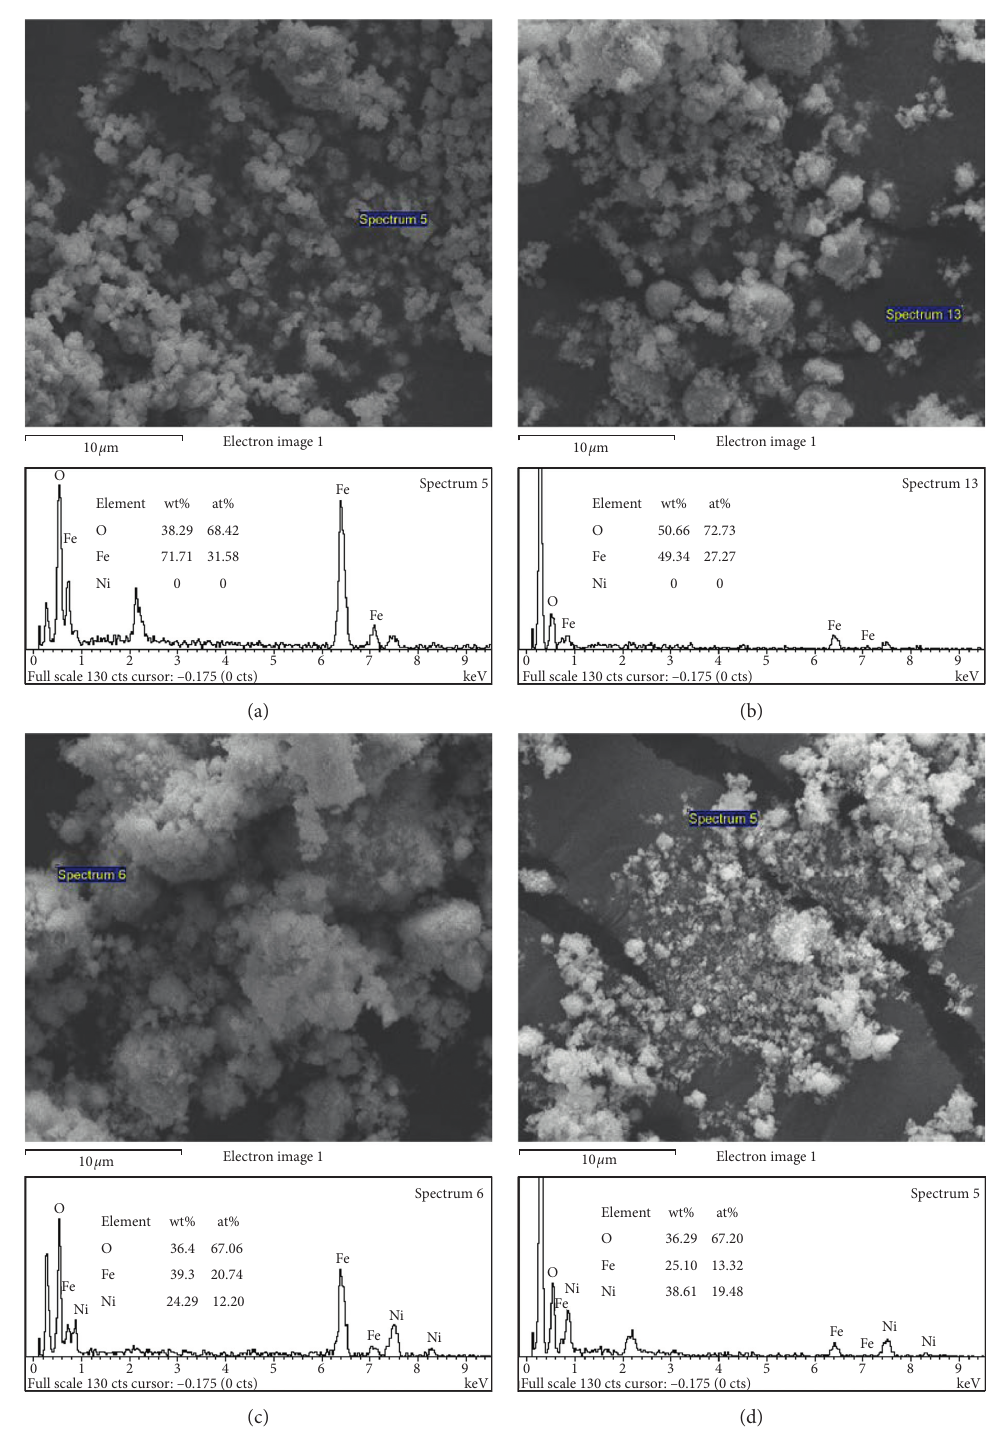
Figure 6: SEI in SEM together with typical EDS spectra of the milled powders with different milling time; (a) for 0 h(b) for 2h (c) for 5 h (d) for